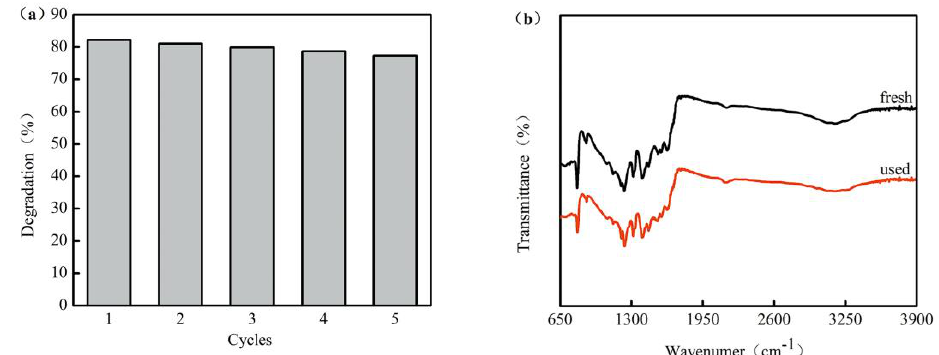
Figure 7. ( a ) Repetitive photocatalytic degradation of naphthalene over biochar ‐ supported K ‐ doped g ‐ C 3 N 4 (mass ratio, 1:0.8) under visible light and ( b ) FTIR spectra of biochar ‐ supported K ‐ doped g ‐ C 3 N 4 (mass ratio, 1:0.8) before and after the photocatalytic reaction.